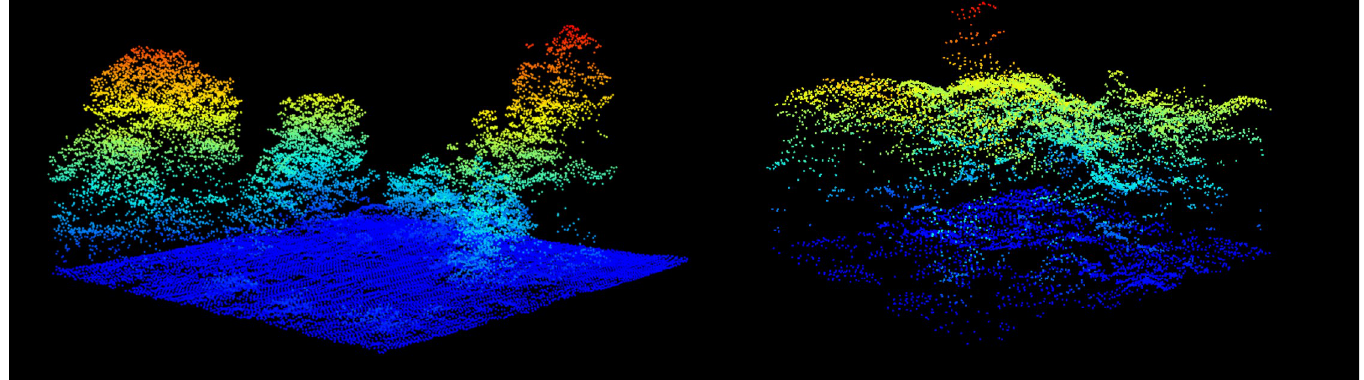
Fig 2. Normalized LIDAR point cloud for evaluation plot SJER_064 from the San Joaquin Experimental Range, California (left) and MLBS_071 from Mountain Lake Biological Station, Virginia. Points are colored by height above ground.